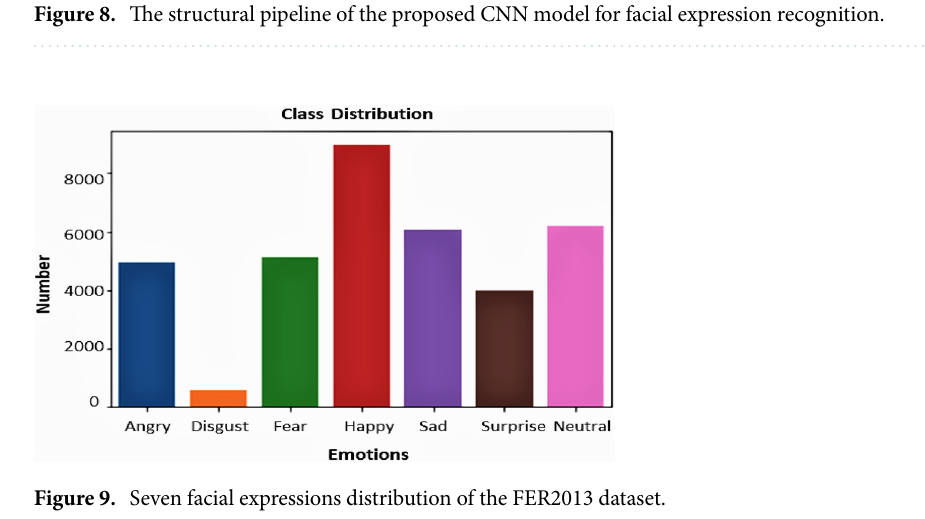
Figure 8. The structural pipeline of the proposed CNN model for facial expression recognition.